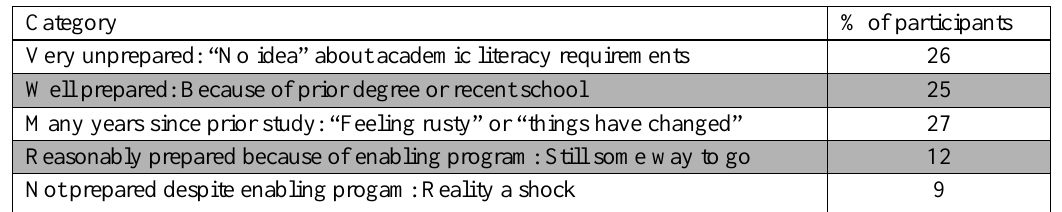
Table 2: Reason for academic literacy self-rating on program entry